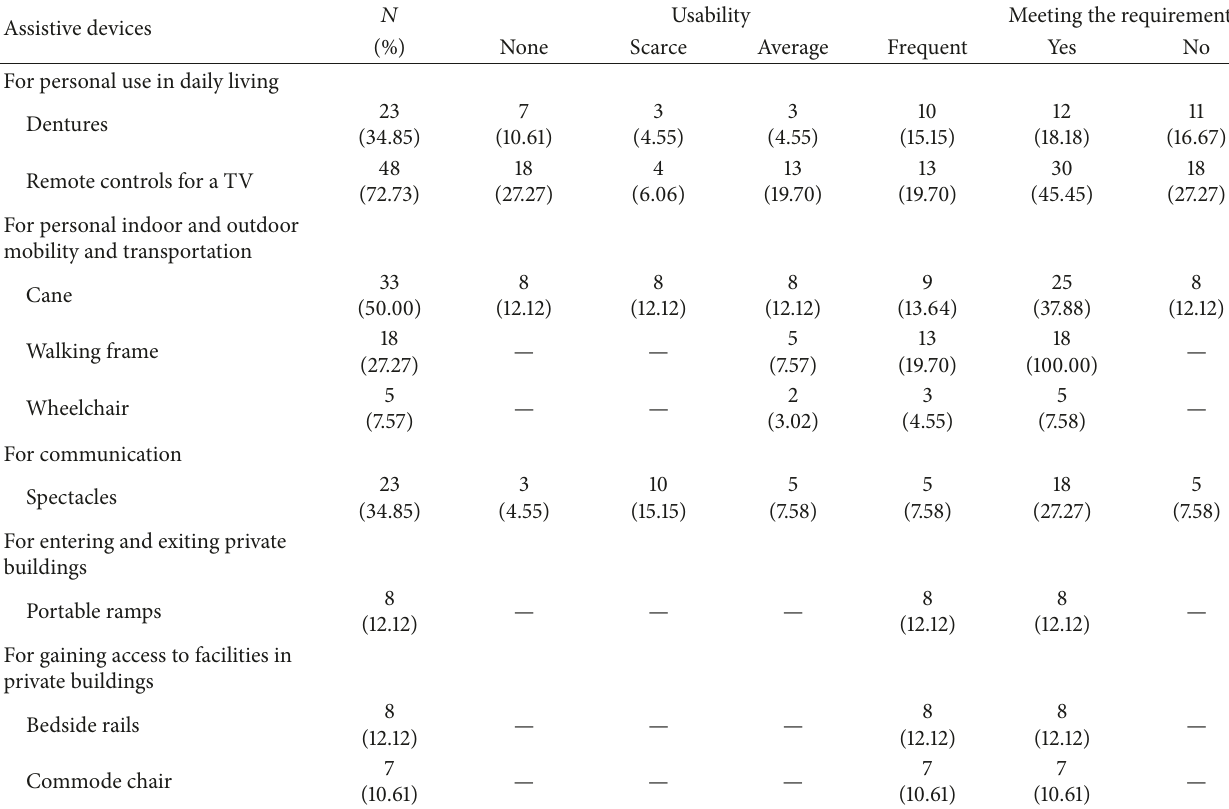
Table 7: Assistive technology in the home for the elderly ( 𝑁 = 66